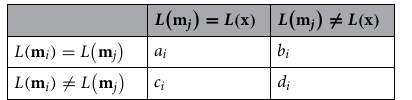
Table 2. Co-occurrence frequency information for each prototype i